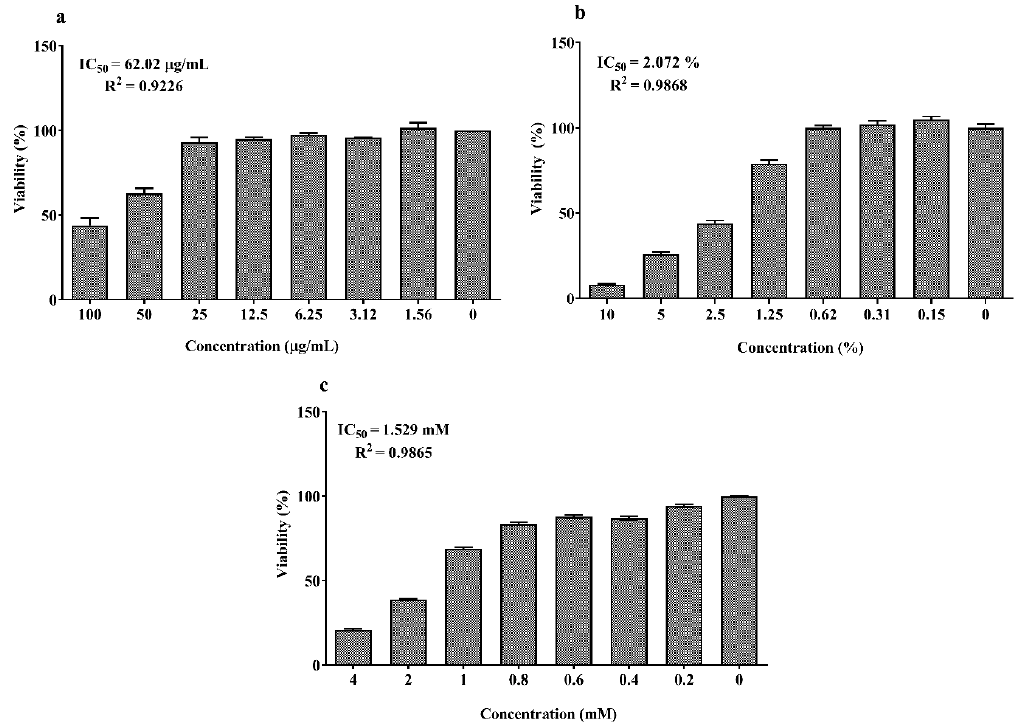
Figure 2. Dose–response effect of ( a ) lipopolysaccharide (LPS) (0–200 μ M) for 24 h; ( b ) dextran sodium sulfate (DSS) (0–10%) for 24 h and ( c ) H 2 O 2 (0–4 mM) for 1 h on IPEC-J2 viability. Data are presented as mean ± SEM ( n = 3, one-way ANOVA). The 50% inhibitory concentrations (IC 50 ) were calculated by non-linear regression analysis and R 2 represents the goodness of fit.